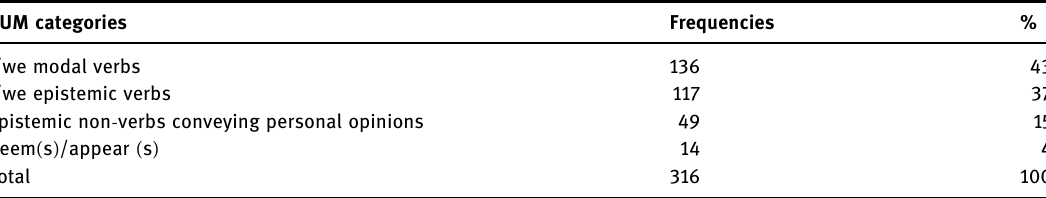
Table 4: Frequencies and percentages of SUM categories in the whole corpus